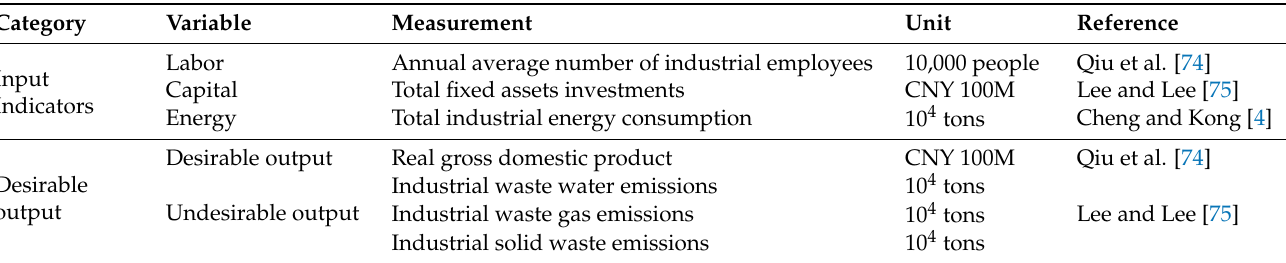
Table 2. GTFP input and output